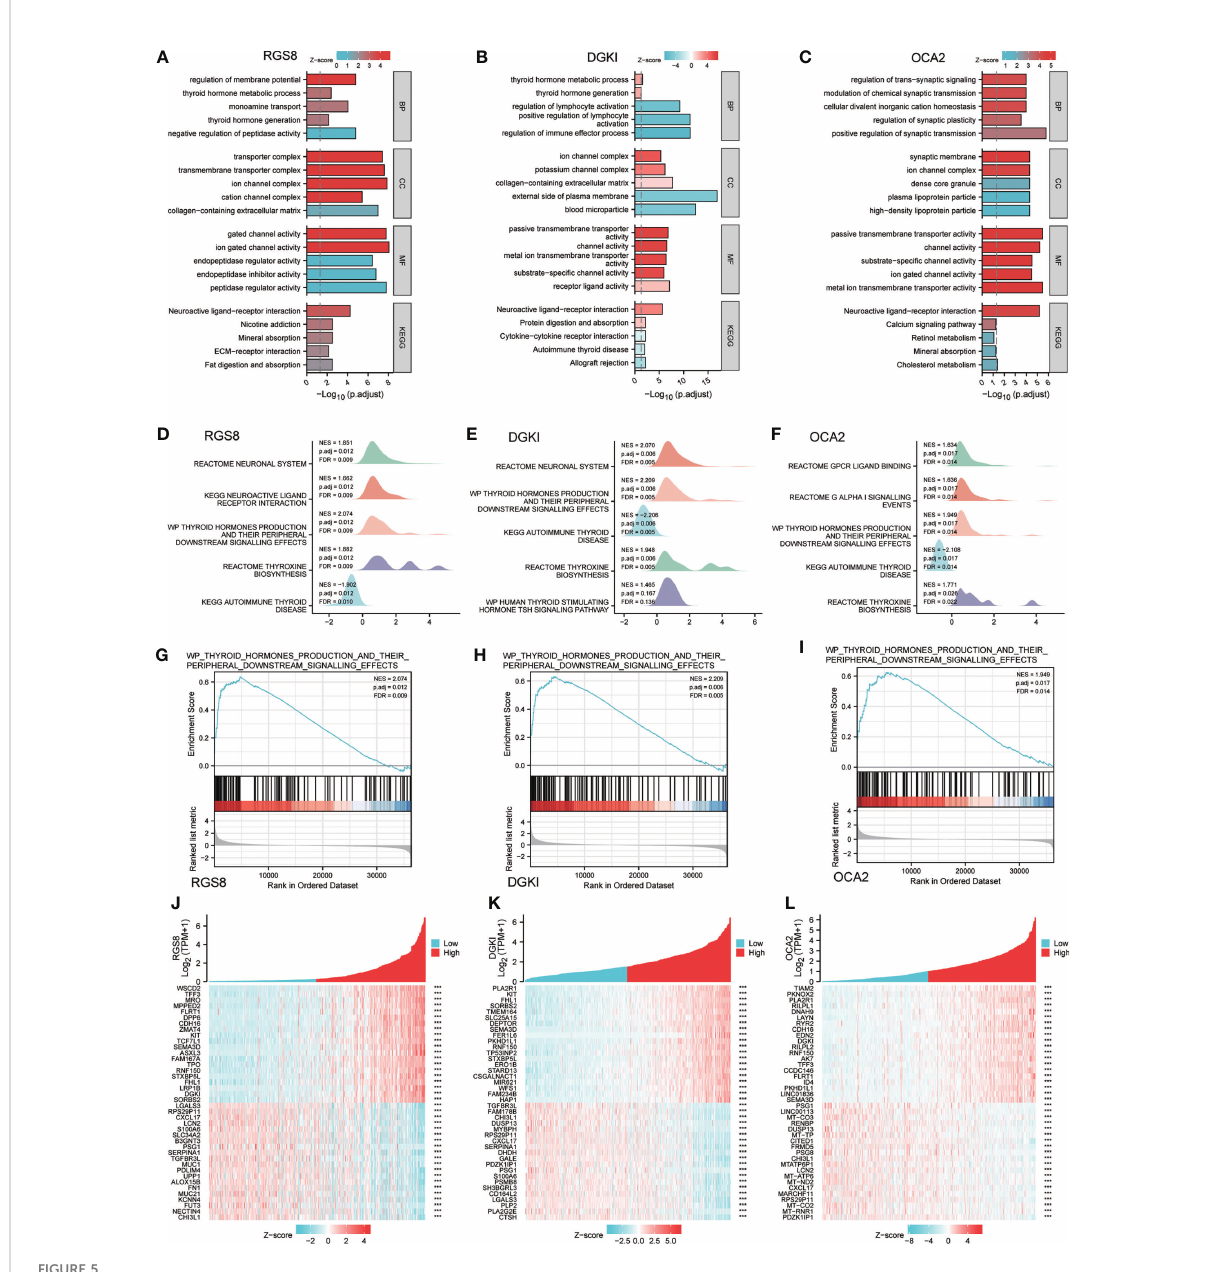
FIGURE 5 Enrichment of biofunction and associated genes analysis of RGS8, DGKI and OCA2 in THCA. The GOKEGG analysis of RGS8 (A) , DGKI (B) , OCA2 (C) . The GSEA of RGS8 (D) , DGKI (E) , OCA2 (F) , and the thyroid hormones production and their peripheral downstream signalling effects of RGS8 (G) , DGKI (H) , OCA2 (I) in GSEA analysis. Heatmap of coexpression patterns of RGS8 (J) , DGKI (K) and OCA2 (L) related genes. ***p <